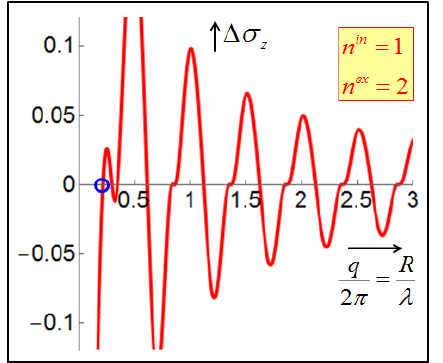
Figure 7: The jump in the specific spin